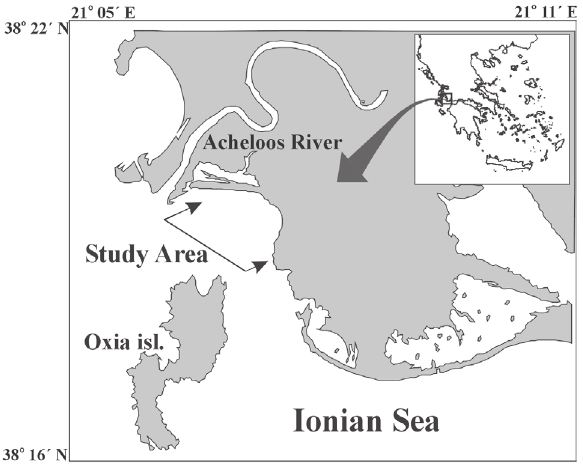
Fig . 1. – location of the study area in western